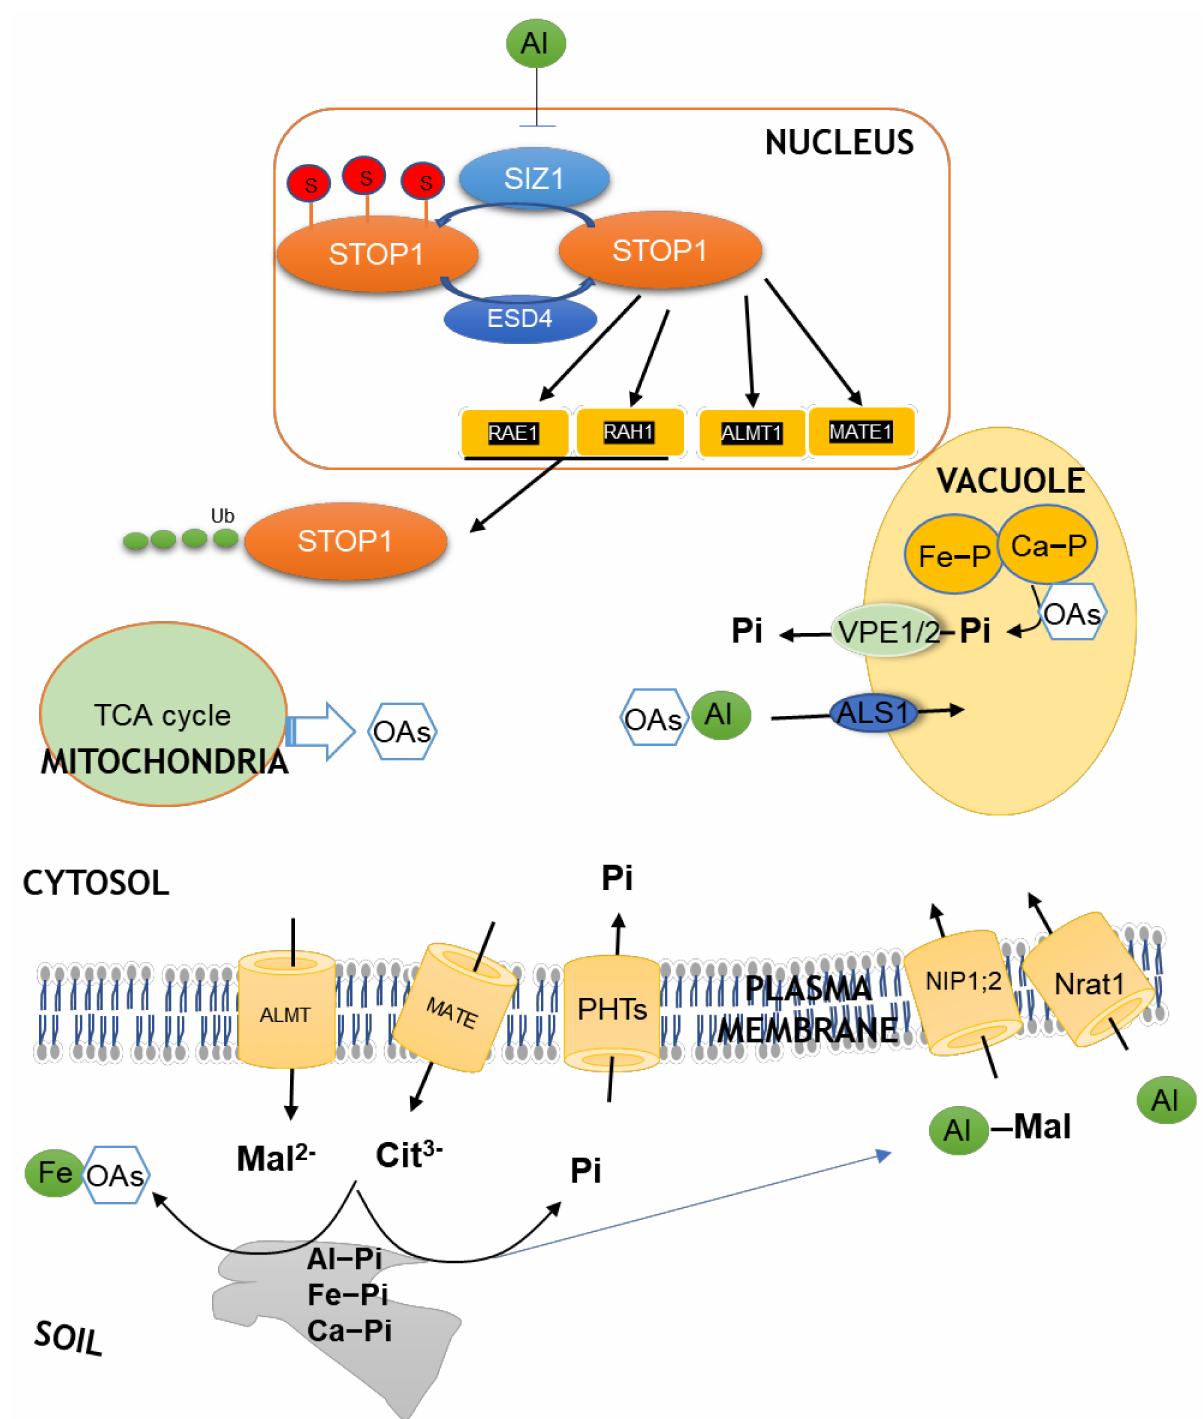
Figure 1. Schematic illustration of the roles of organic acid anions (OAs) and their metabolism regulation in Al detoxification and P solubilization on acidic soils. The OAs are produced mainly through mitochondria tricarboxylic acid (TCA) cycle. Under stress conditions, stress signals trigger the transcription factor STOP1 via SUMOylation and ubiquitination regulation to induce the transcription of transporter genes that are responsible for OAs exudation, Pi uptake, and Al complexation and